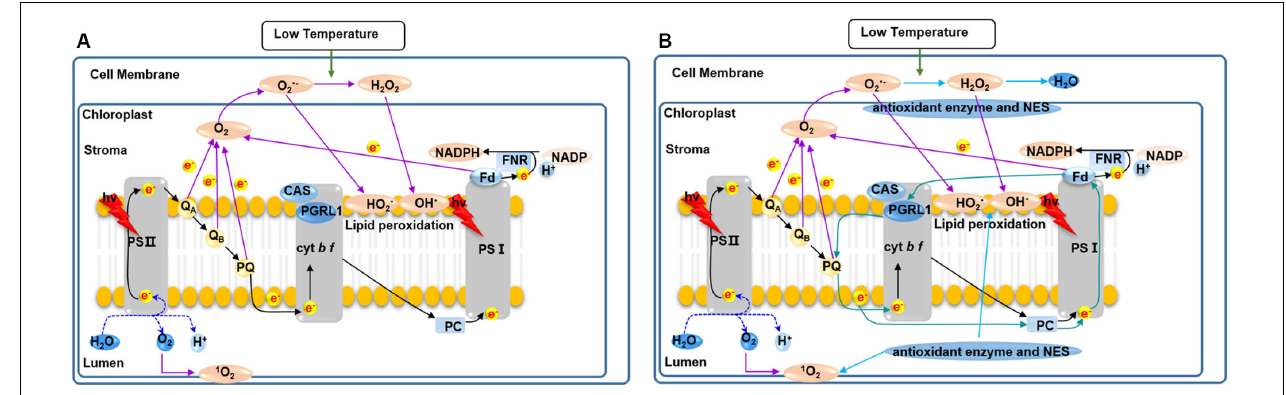
FIGURE 10 | An outline of the putative response mechanisms of C. nivalis and C. reinhardtii at low temperatures. (A) C. reinhardtii . (B) C. nivalis. Black arrows, linear electron transfer. Atrovirens arrows, cyclic electron transport. Purple arrows, ROS generation. Blue arrows, ROS scavenging. NES, non-enzymatic ROS scavengers. When C. nivalis is exposed to low temperatures, the cyclic electron flow helps to eliminate excess light energy, while the activities of the antioxidant enzymes reduce oxidative